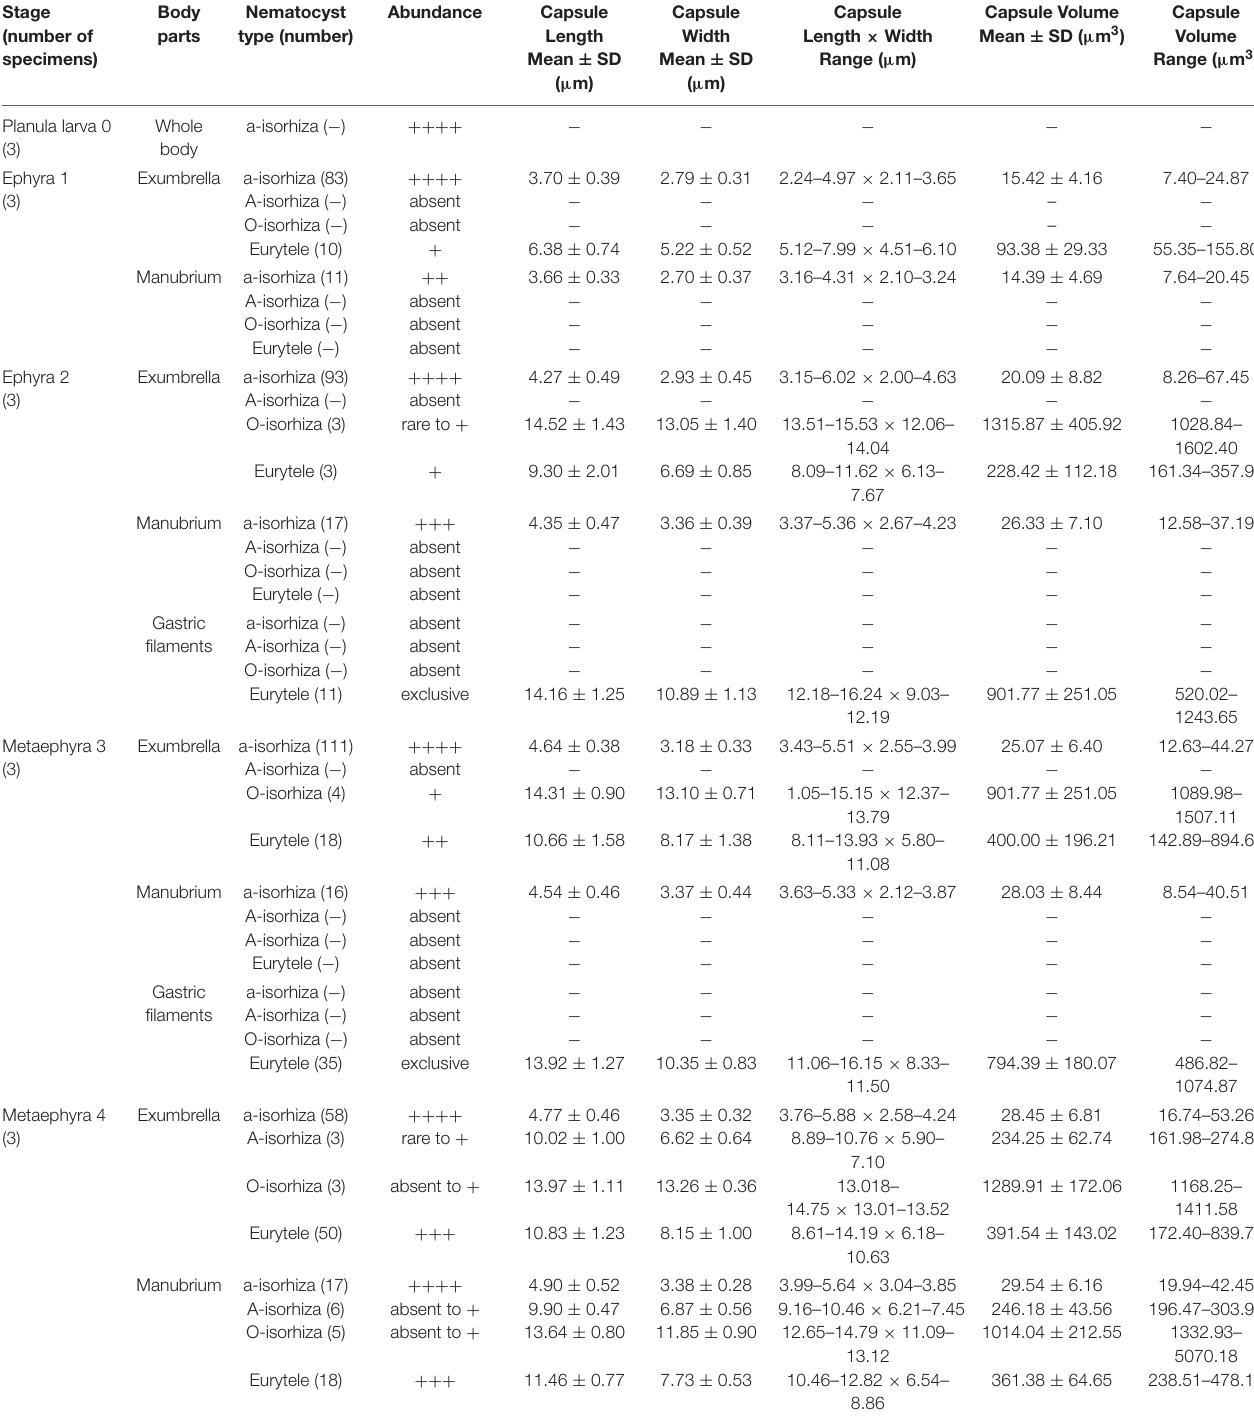
TABLE 2 | Nematocyst capsule, abundance and measurements from different body parts in each stage during Pelagia noctiluca life cycle. Stage (number